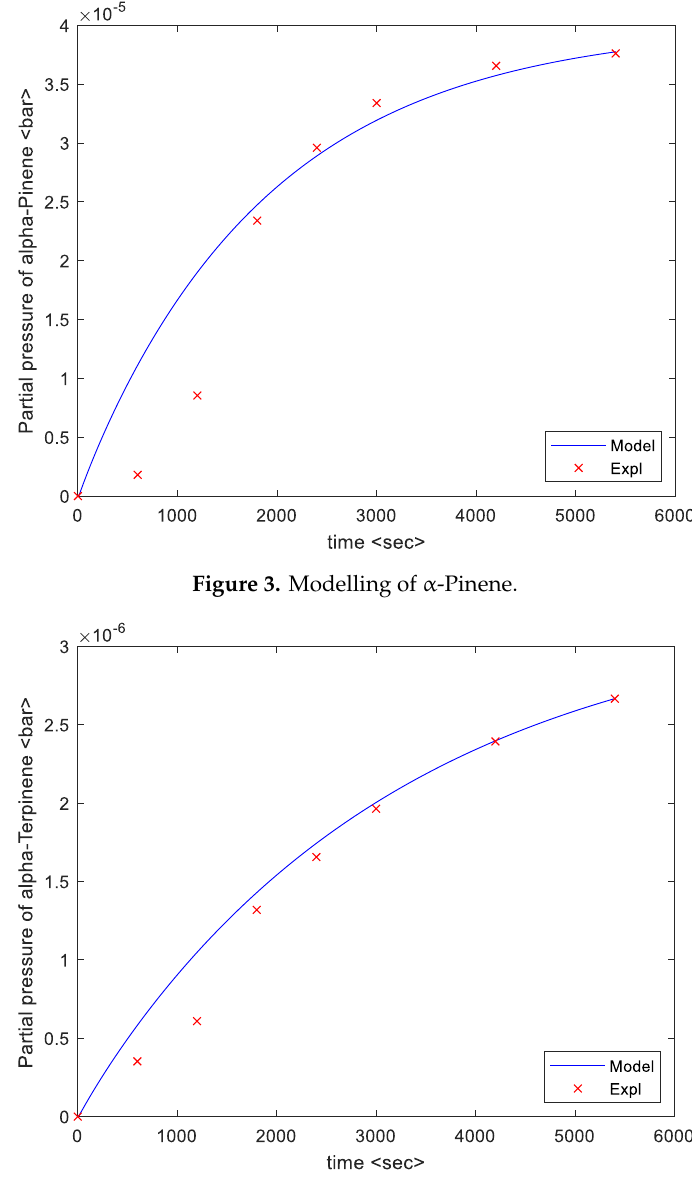
Figure 4. Modelling of α-terpinene.